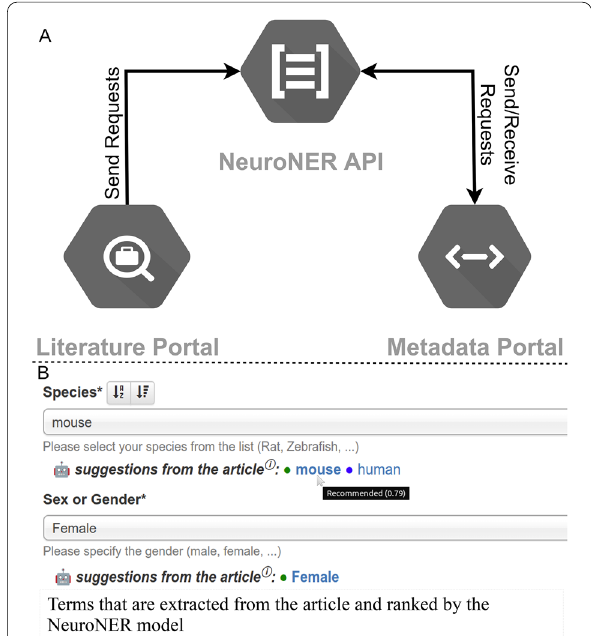
Fig. 8 A API interactions between NeuroMorpho.Org functionalities. When a relevant article is identified, the literature portal sends a request to the NeuroNER API with a pointer to the article identifier. The API then processes the request and sends the extraction labels back to the metadata portal. B Enhanced graphical user interface of the metadata portal. For different metadata dimensions (e.g., species and sex), the web form now shows a sorted list of clickable suggestions automatically extracted from the article text. The color coding reflects the level of confidence associated with the suggestion: green (recommended): score 0.78; blue (suggested): ≥ 0.78 > score 0.45; scores below 0.45 are ≥